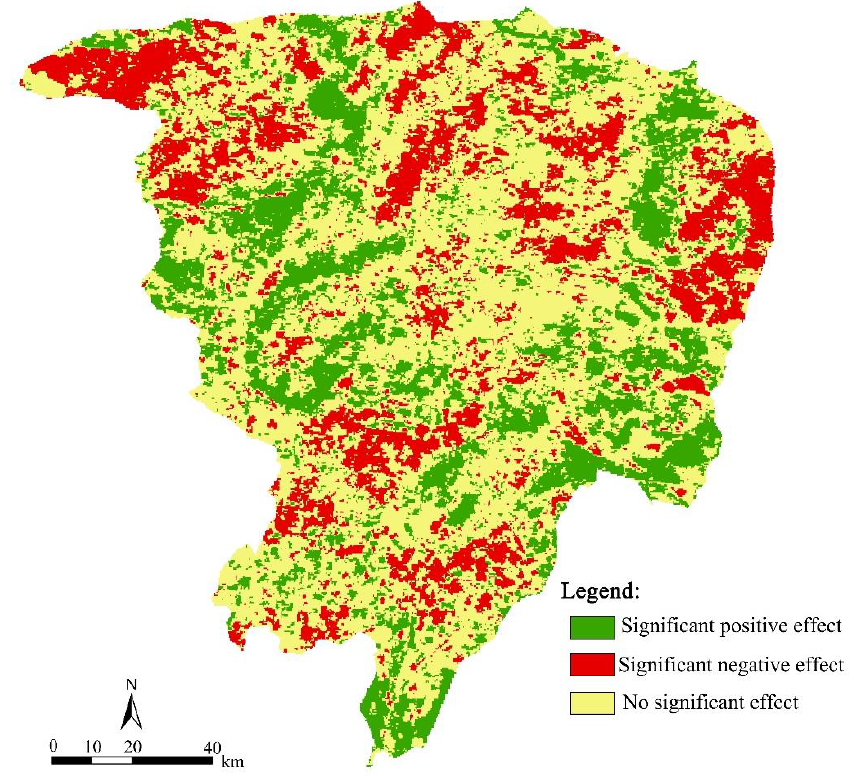
Figure 15. Spatial distribution of human activities on aeolian desertification in the Zhenglan Banner. Human activities in the green areas were conducive to the reversal of desertification. Human activities in the red areas made desertification more serious. Human activities in the yellow areas had no obvious impact, and climate factors played a major role.